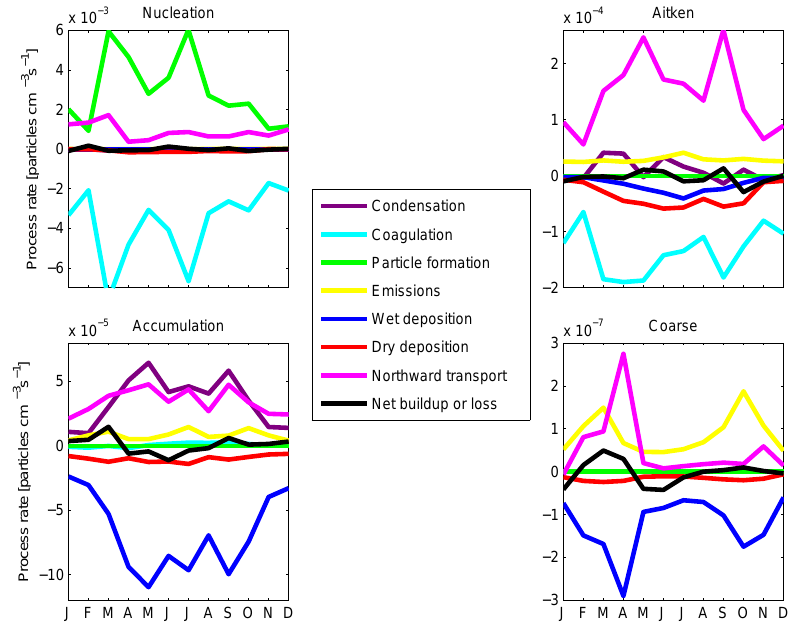
Figure 8. Monthly and Arctic mean aerosol number process rates for the entire Arctic troposphere (north of 66 ◦ N) for simulation NEWSCAV + COAG. Processes considered for each of four size ranges are condensation, coagulation, particle formation, primary emissions, wet and dry deposition, transport across 66 ◦ N, and net regional buildup or loss rates. The aerosol size ranges are nucleation ( D p < 10nm), Aitken (10 <D p < 100nm), accumulation (100 <D p < 1000nm), and coarse ( D p >